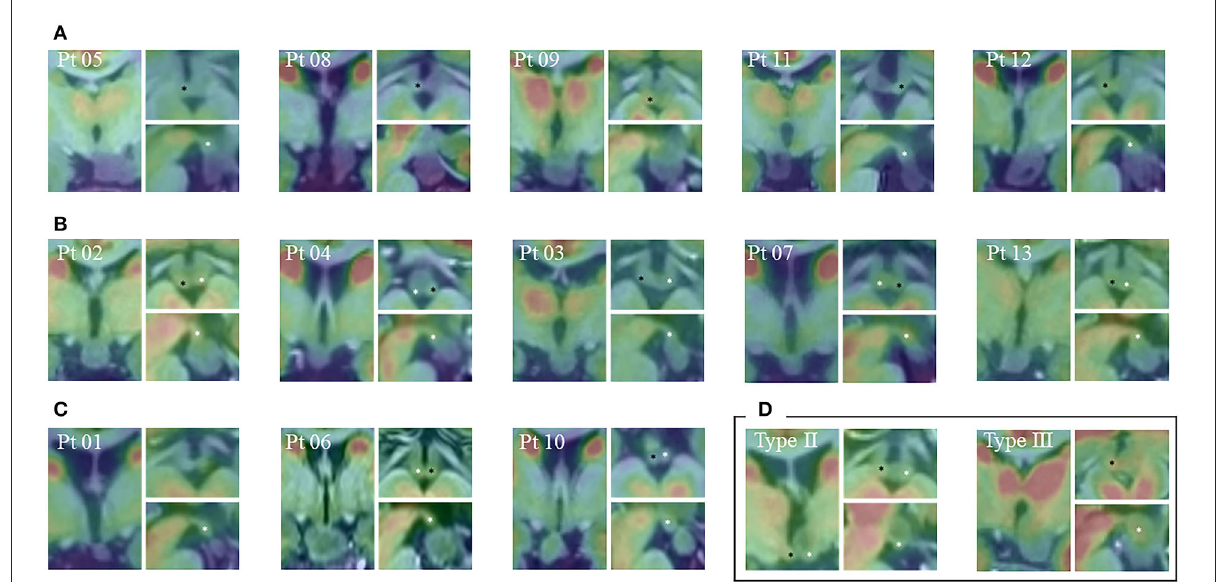
FIGURE2 Co-registered images from MRI and PET-CT of each patient by coronal (left), axial (upper right), and sagittal (lower right) scans. Ipsilateral MB and contralateral MB are marked by white and black asterisks, respectively. (A) Five patients from Group 1 showed that the hypothalamic connection was established only on one side of the subventricular floor by a sessile attachment, with invaded ipsilateral MB and preserved contralateral MB. (B) Five patients from Group 2 showed that HH adheres to both TC and MB outside the third ventricle. In this way, the lesion was bilaterally connected to the MB by its caudal part, and on the coronal plane, narrow attachments were observed on both sides. (C) Three patients from Group 3 showed HH horizontally oriented from TC; therefore, the lesion adhered to the subventricular floor only by a pedunculated attachment, being suspended and sparing the MB. (D) The relationship between MB and other Delalande types of lesions. MRI, magnetic resonance imaging; PET-CT, positron emission tomography-computed tomography; MB, mammillary bodies; HH, hypothalamic hamartoma; TC, tuber